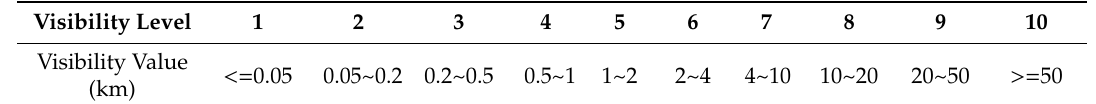
Table 1. Rule for classifying the visibility level.